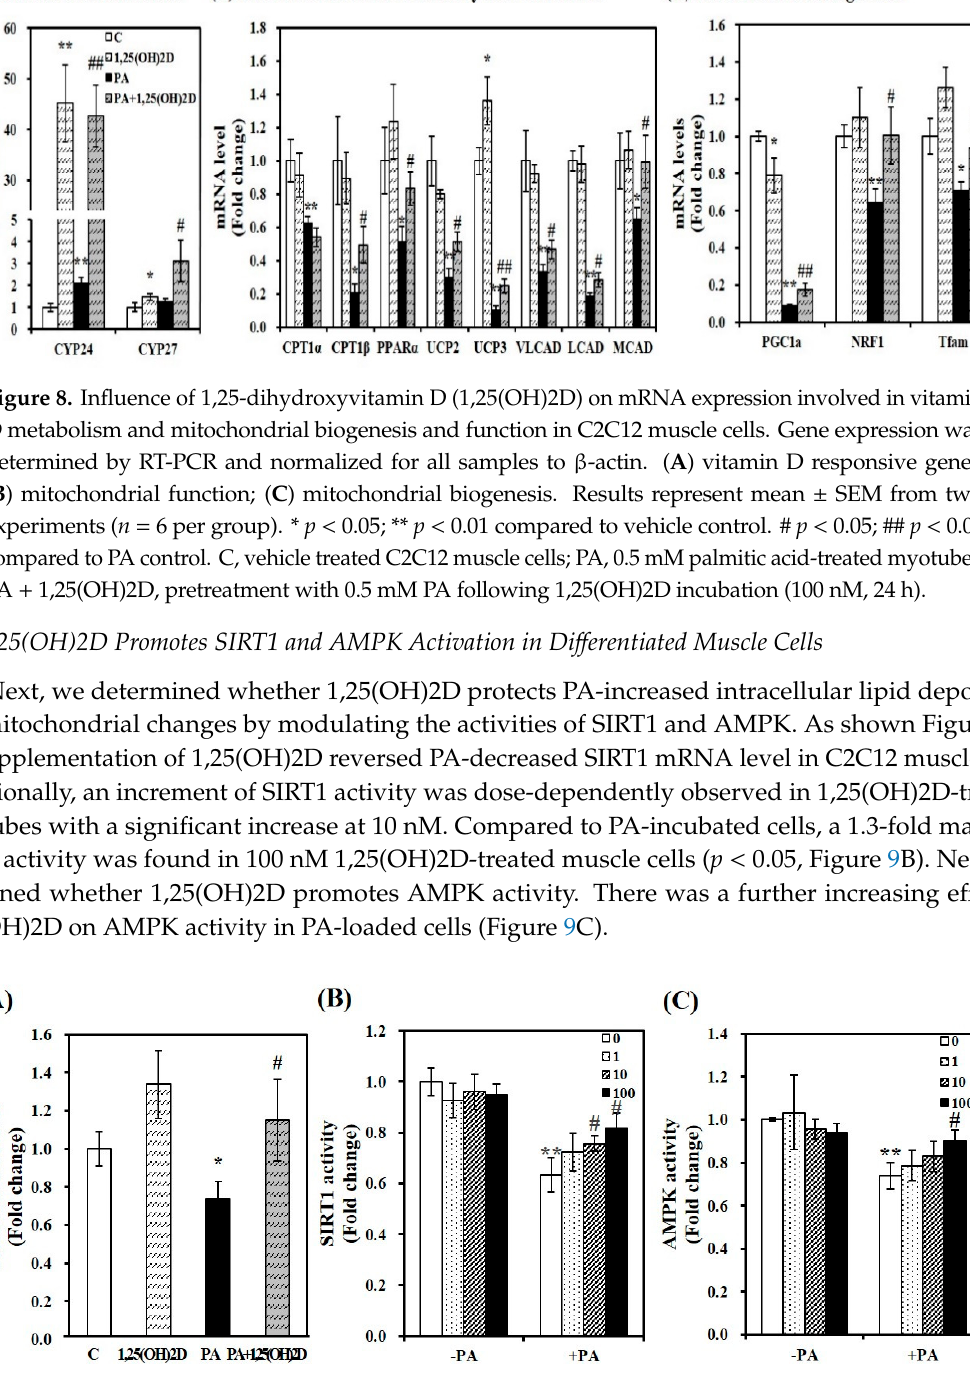
Figure 9. 1,25-dihydroxyvitamin D (1,25(OH)2D) increases SIRT1 gene expression and AMPK/SIRT1 activation in C2C12 muscle cells. SIRT1 mRNA levels were determined by RT-PCR and normalized for all samples to β -actin ( A ). SIRT1 activity ( B ) and AMPK activity ( C ) were analyzed by a fluorometric SIRT1 activity assay kit or an AMPK kinase kit, normalized to their relative protein concentrations, and expressed as the fold change compared to the vehicle control. The value of each bar represents mean ± SEM. Experiments represent at least two or three independent experiments ( n = 6–8 per group). * p < 0.05; ** p < 0.01 compared to vehicle control. # p < 0.05 compared to PA control. C, vehicle treated C2C12 muscle cells; PA, 0.5 mM palmitic acid-treated myotubes; PA + 1,25(OH)2D, pretreatment with 0.5 mM PA following 1,25(OH)2D incubation (100 nM, 24 h).